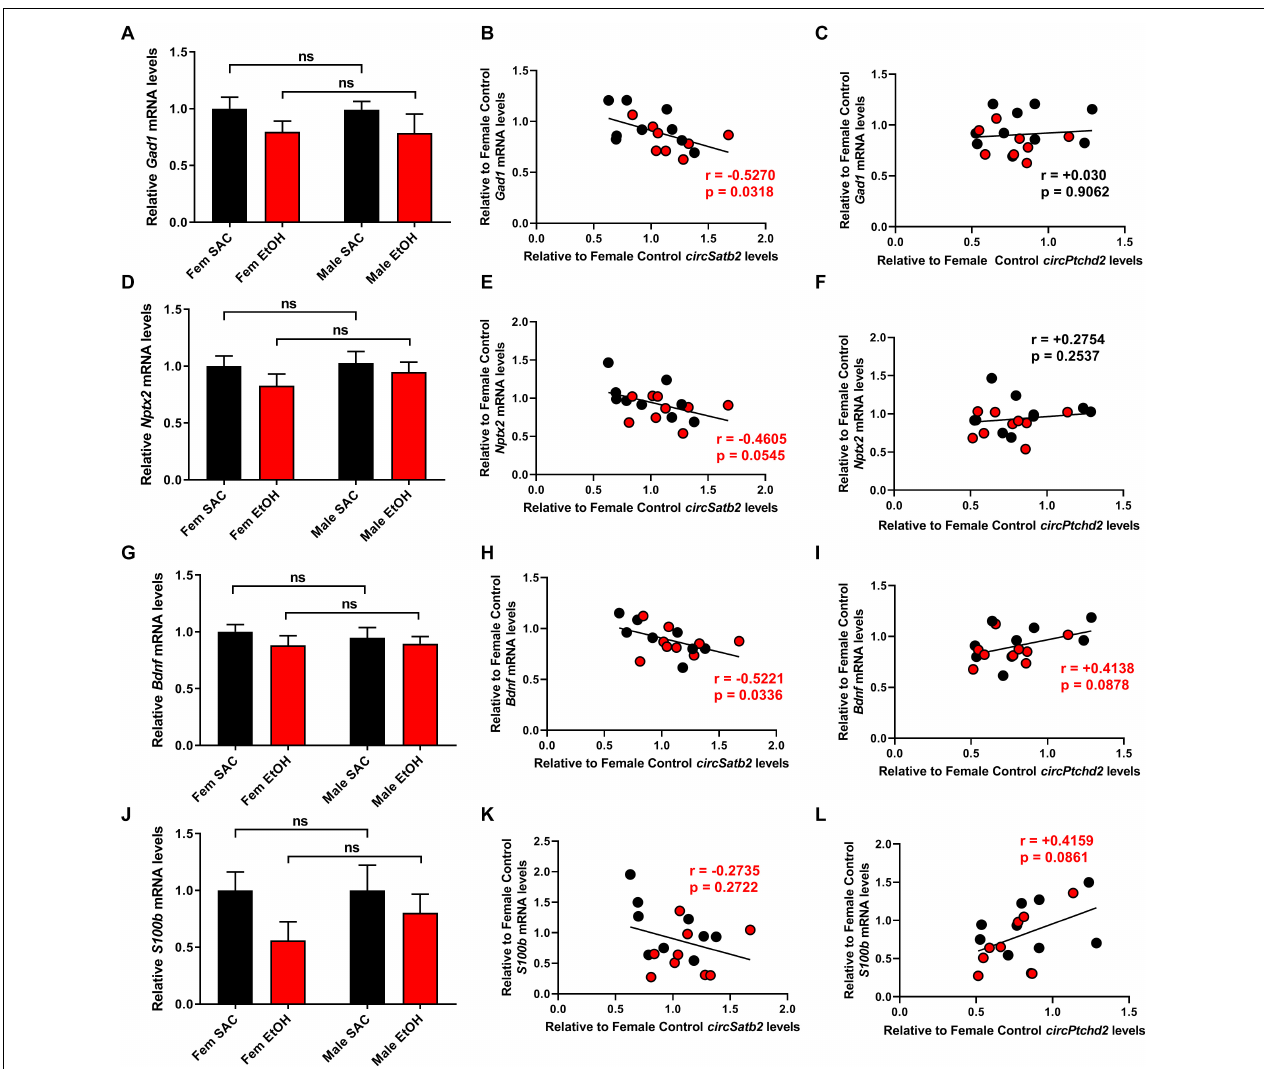
FIGURE 5 | Changes in circPtchd2 and circSatb2 expression in prenatal brain are correlated with neuronal and glial gene expression. (A,D,G,J) Bar graphs showing mean + SEM of neuronal and glial gene mRNAs relative to female SAC (control), based on qRT-PCR and normalized to 18SrRNA . No sex-specific significant difference between control (black bars) and PAE groups (red bars) was observed in (A) Gad1 , (D) Nptx2 , (G) Bdnf , and (J) S100b mRNA levels. (B–L) Correlations (two-tailed Spearman’s) between circSatb2 and Gad1 , Nptx2 , Bdnf , and S100b mRNA expression (B,E,H,K) and circPtcd2 and Gad1 , Nptx2 , Bdnf , and S100b mRNA expression (C,F,I,L) mRNA levels. For (A,D,G,J) , N = 5–6 per group. Male SAC, female SAC, male PAE, and female PAE samples are all included in the correlations